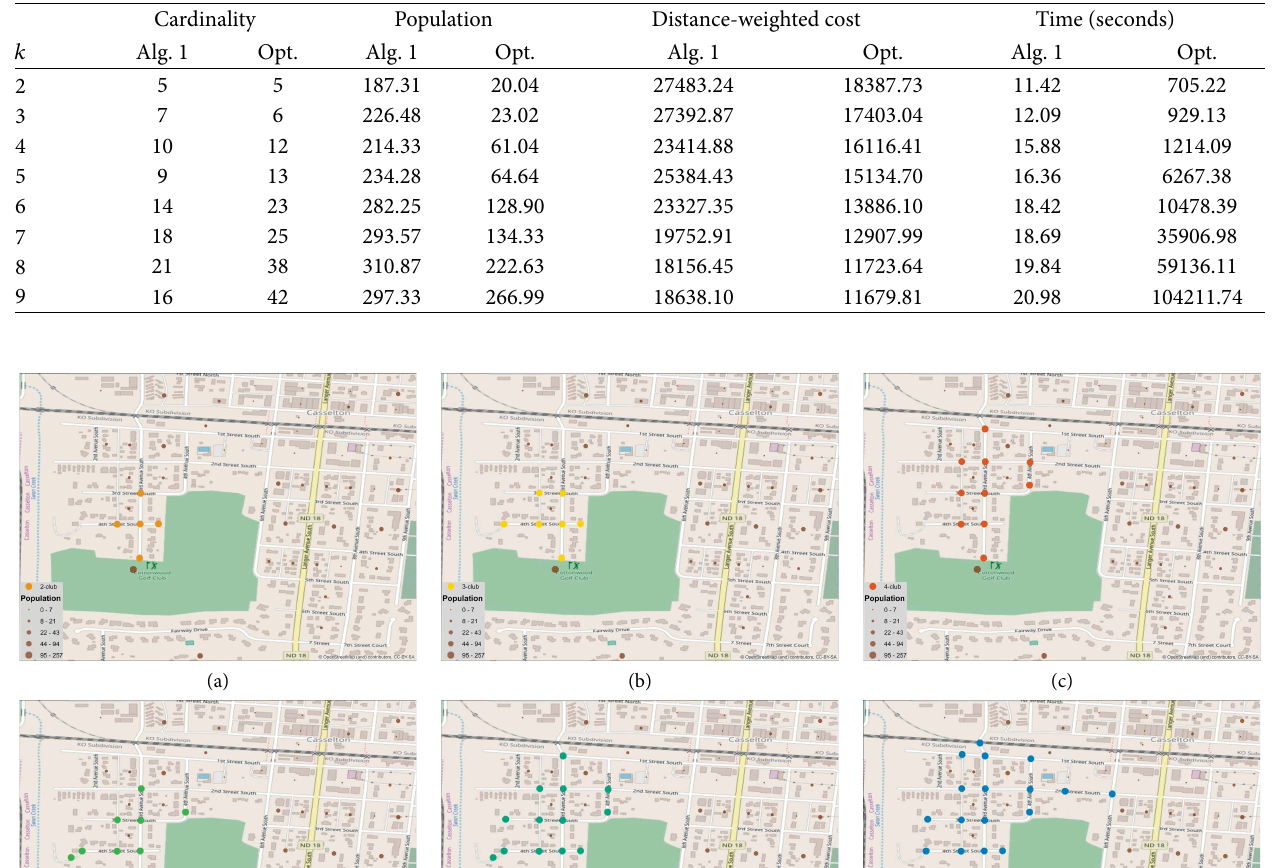
Table 2: Numerical results for Casselton.